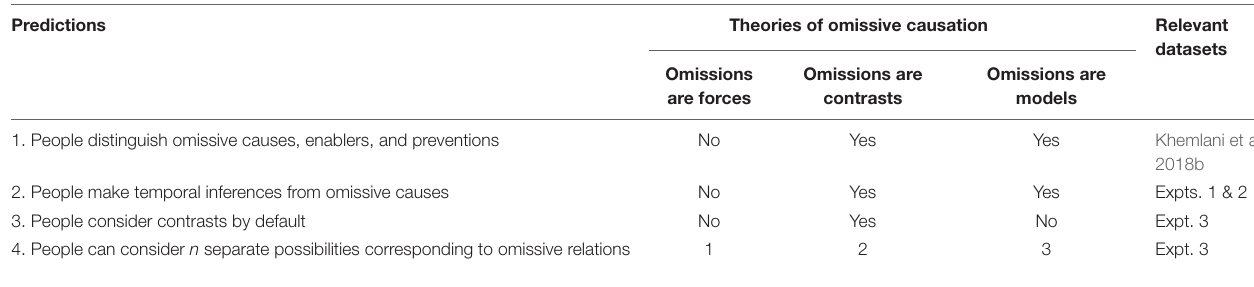
TABLE 1 | Predictions of the theoretical proposals of the representation of omissive causes as well as the datasets that test the various predictions.